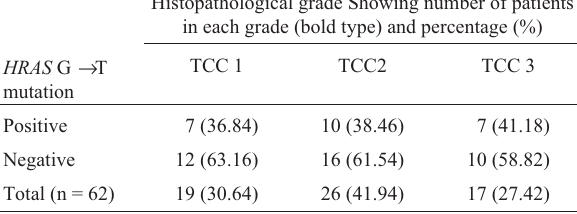
Table 1 - Distribution of patients according to G → T mutation at codon 12 of the HRAS oncogene and histopathological grade of transitional cell carcinoma (TCC)